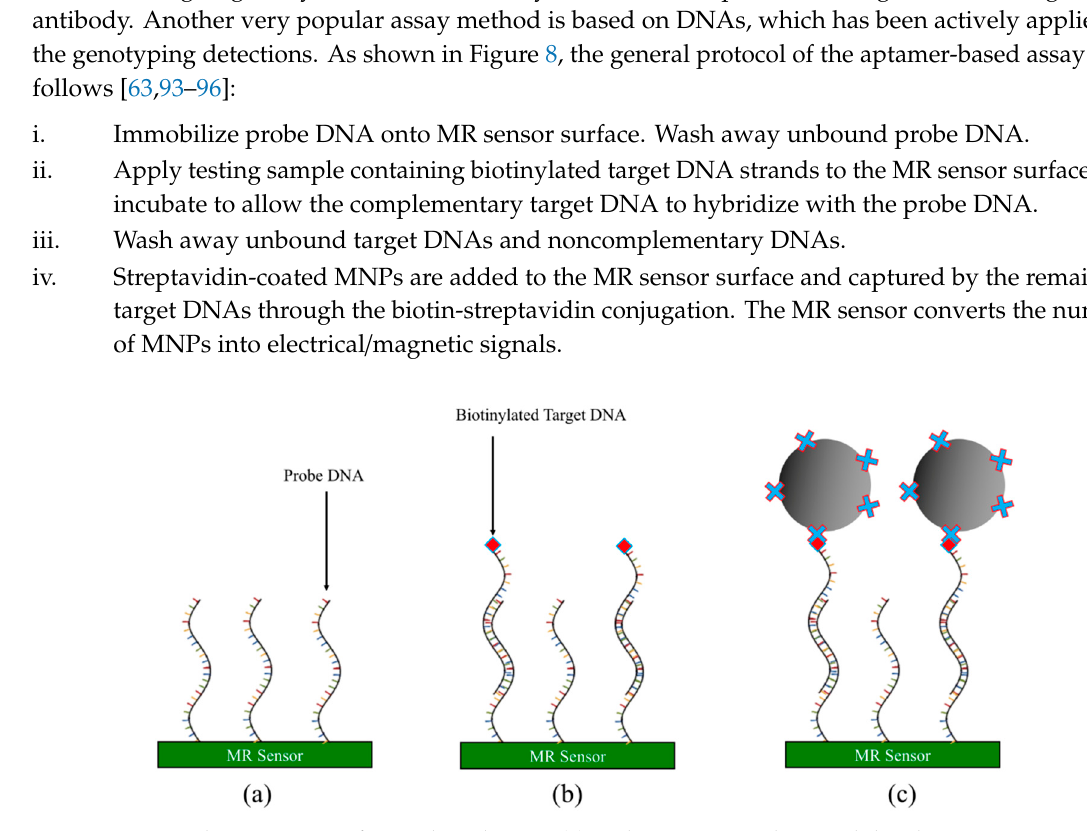
Figure 8. Schematic view of DNA-based assay. ( a ) Probe DNA strands immobilized onto MR sensor surface; ( b ) biotinylated target DNA hybridizes with probe DNA; ( c ) streptavidin-coated MNPs captured by target DNAs through biotin-streptavidin